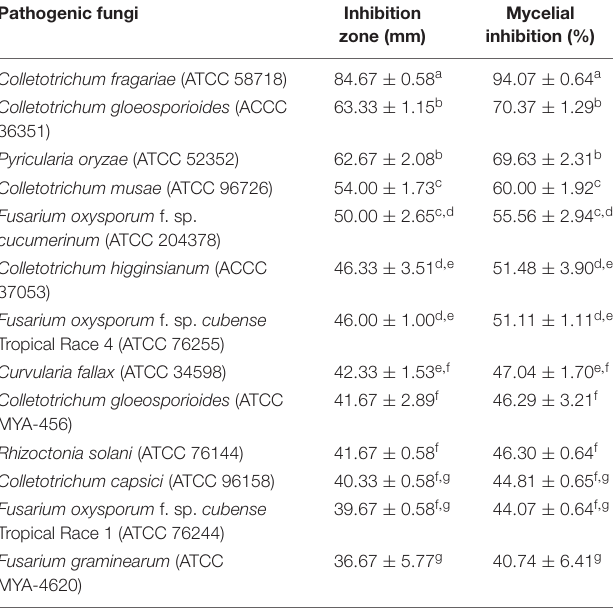
TABLE 5 | Minimum inhibitory concentration values of crude extracts of TABLE 4 | Inhibitory activities of Streptomyces sp. SCA3-4 against plant Streptomyces sp. SCA3-4 against 13 pathogenic fungi. pathogenic fungi. Pathogenic fungi Inhibition Mycelial Pathogenic fungi zone (mm)